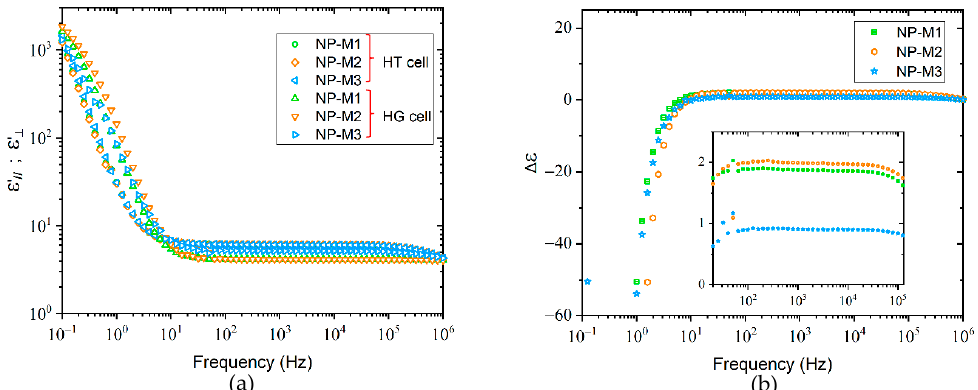
Figure 2. ( a ) Relative permittivity and ( b ) dielectric anisotropy of three non-purified LC mixtures as function of frequency. Measurements were taken at 1 V and room temperature (20 °C) with 20 µm cells in homogeneous and homeotropic alignments. NP-M stands for non-purified LCs mixtures.